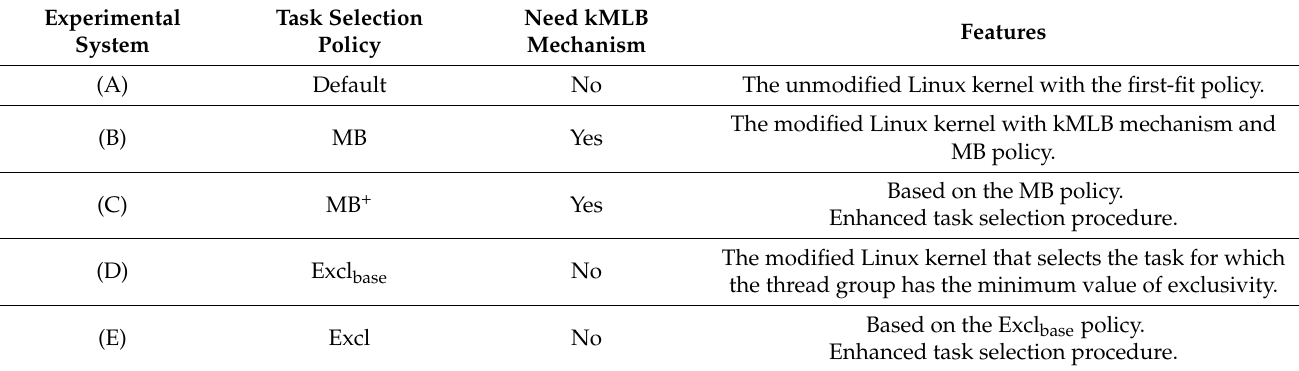
Table 6. The experimental system running different task selection policies.